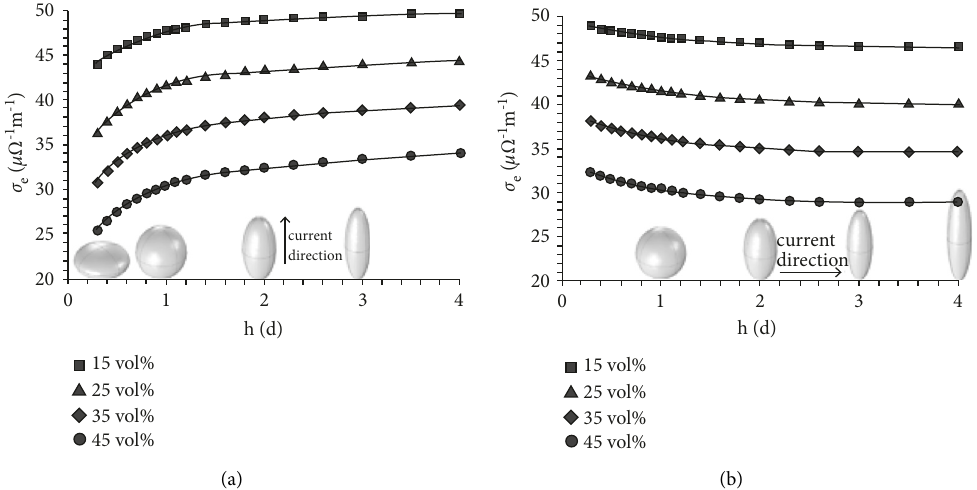
Figure 7: Influence of the shape of Cr particles in the Cu matrix on the electrical conductivity: transition from platelet-like (h/d < 1) over spherical (h/d � 1) to needle-like (h/d > 1) particles for a simulation (a) parallel and (b) perpendicular to the main scaling axis [14].